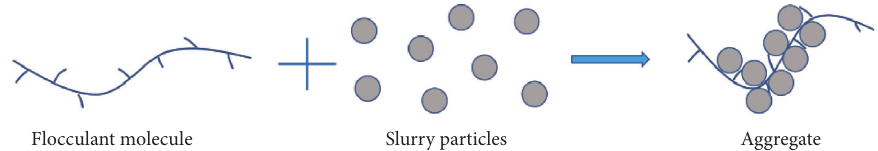
Figure 10: Illustration of the function of flocculant adsorption bridging (adapted from [29]).